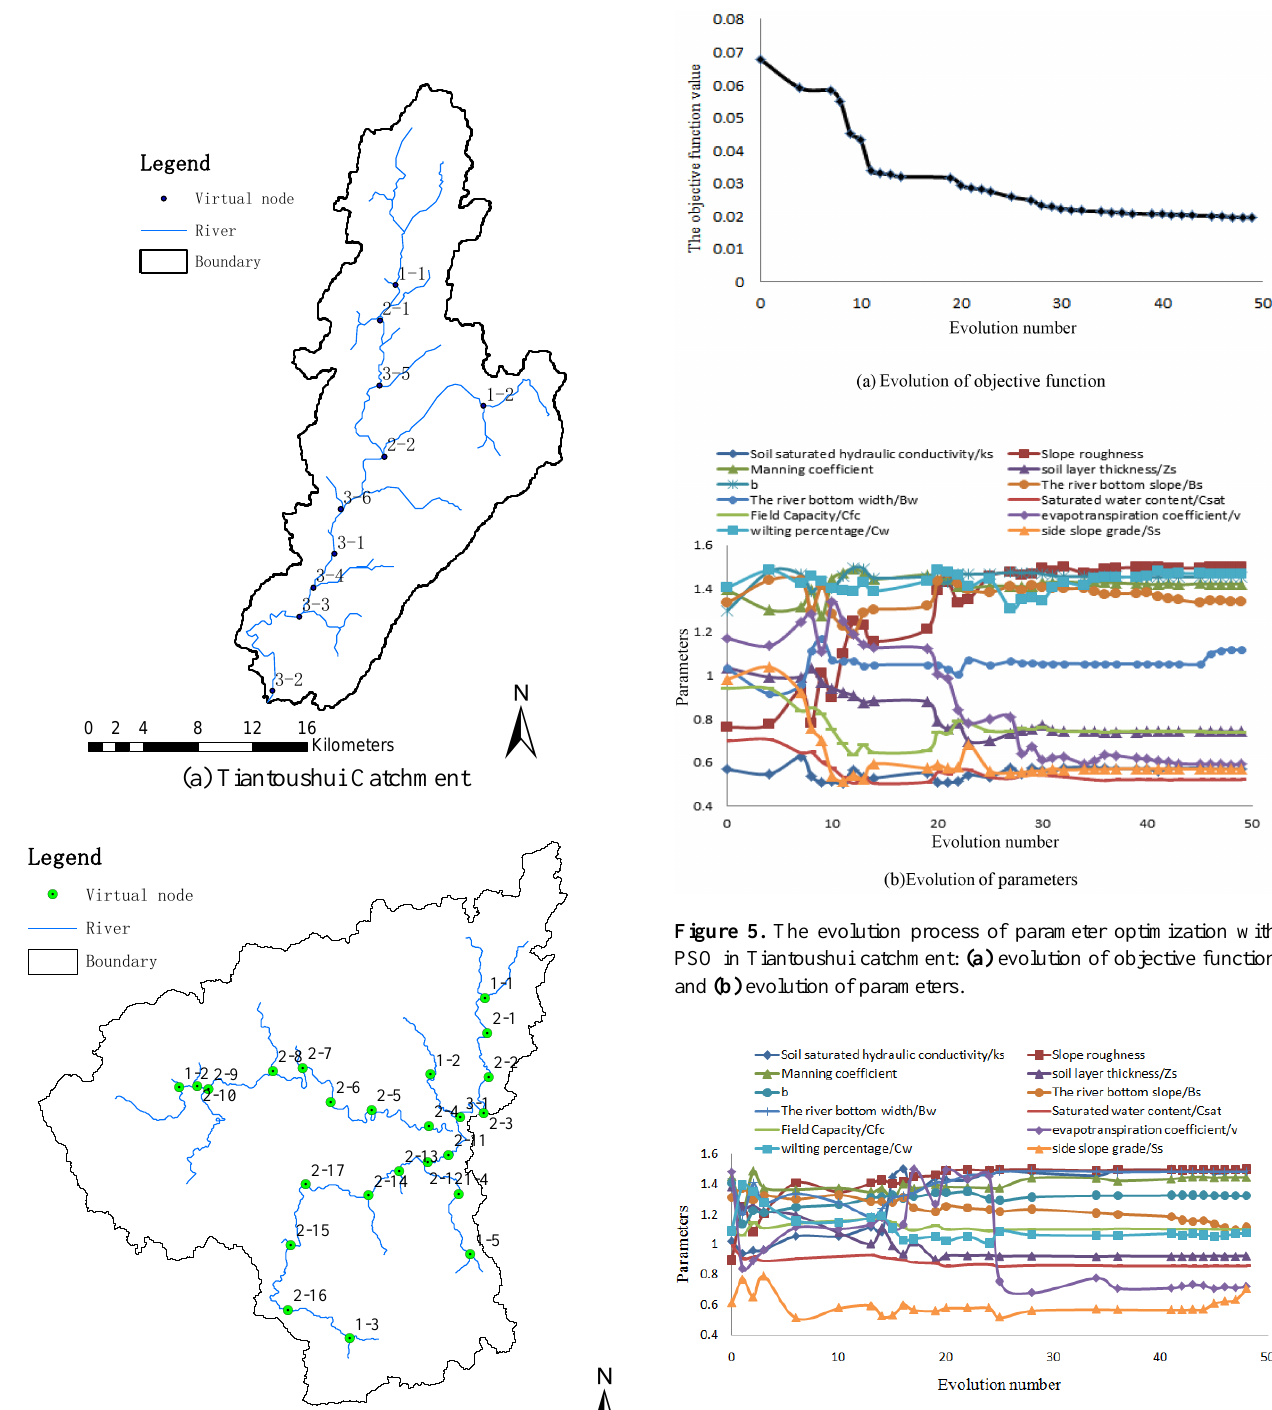
Figure 6. The evolution processes of parameter optimization with PSO in